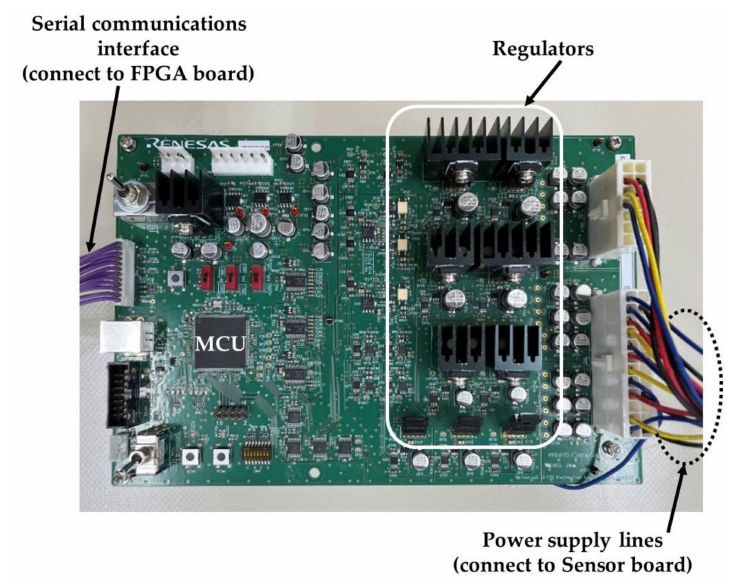
Figure 14. Programmable power supply board.